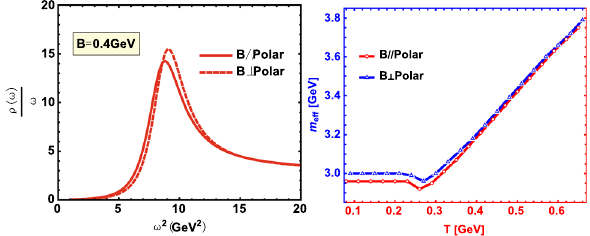
Fig. 8 The effective mass of ϒ( 1 S ) state for different magnetic field B at μ = 0GeV . The left picture is for magnetic field parallel to polarization and the right one is for magnetic field perpendicular to polarization